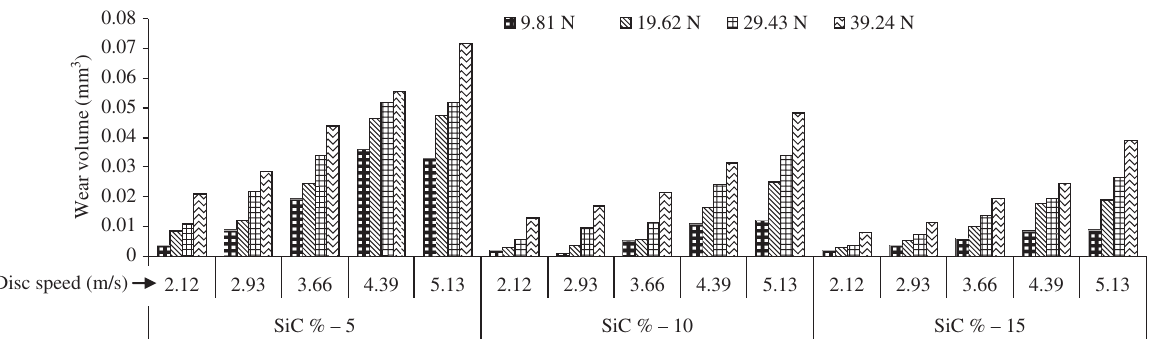
Figure 4 Variation of wear volume with speed, load and material composition.